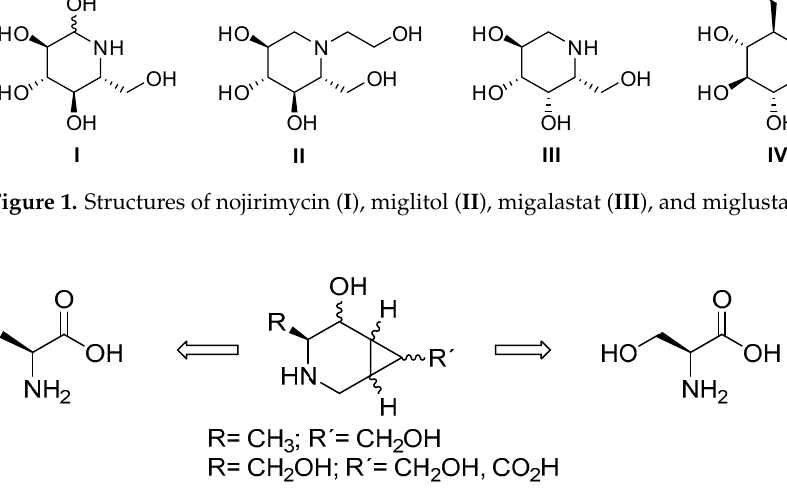
Figure 2. Structures of the targeted compounds.